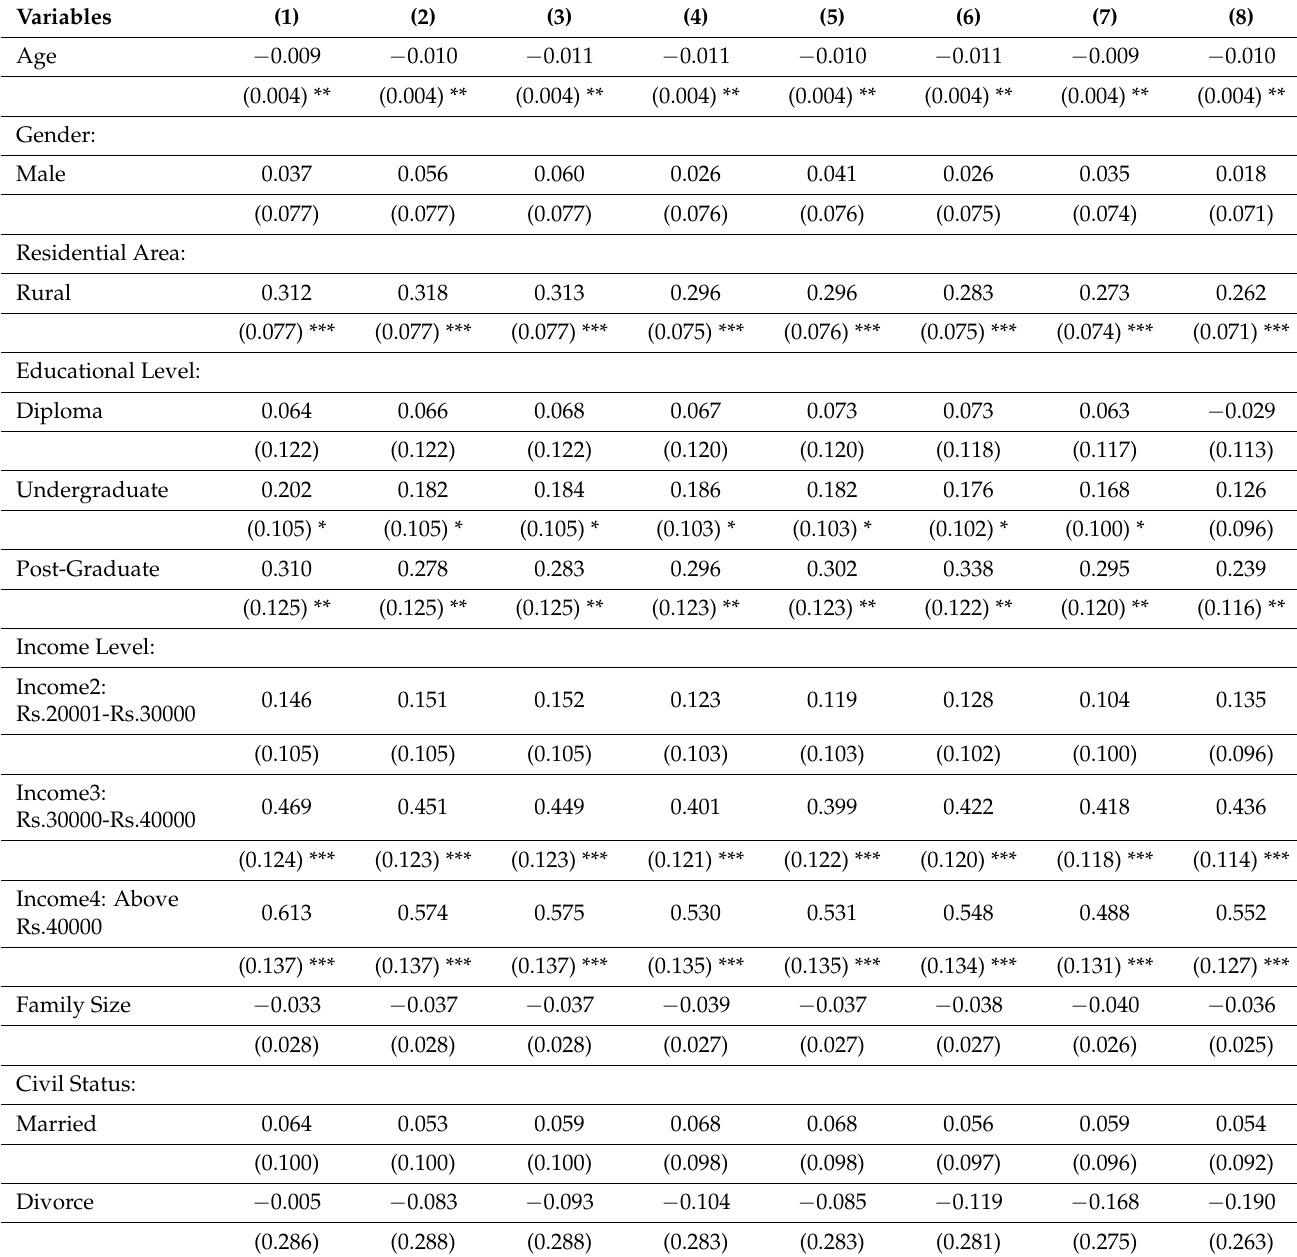
Table 5. Double Bounded Dichotomous Choice Hierarchical